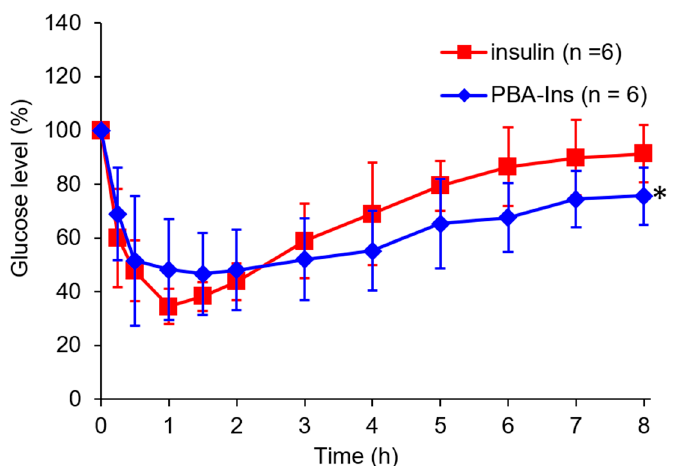
Figure 3. Blood glucose level profile after intravenous injection of 190 µ g / kg insulin or PBA-Ins. Each value presents mean ± S.D. ( n = 6); * means p < 0.05 at 8 h after intravenous administration, calculated using Student’s t -test.